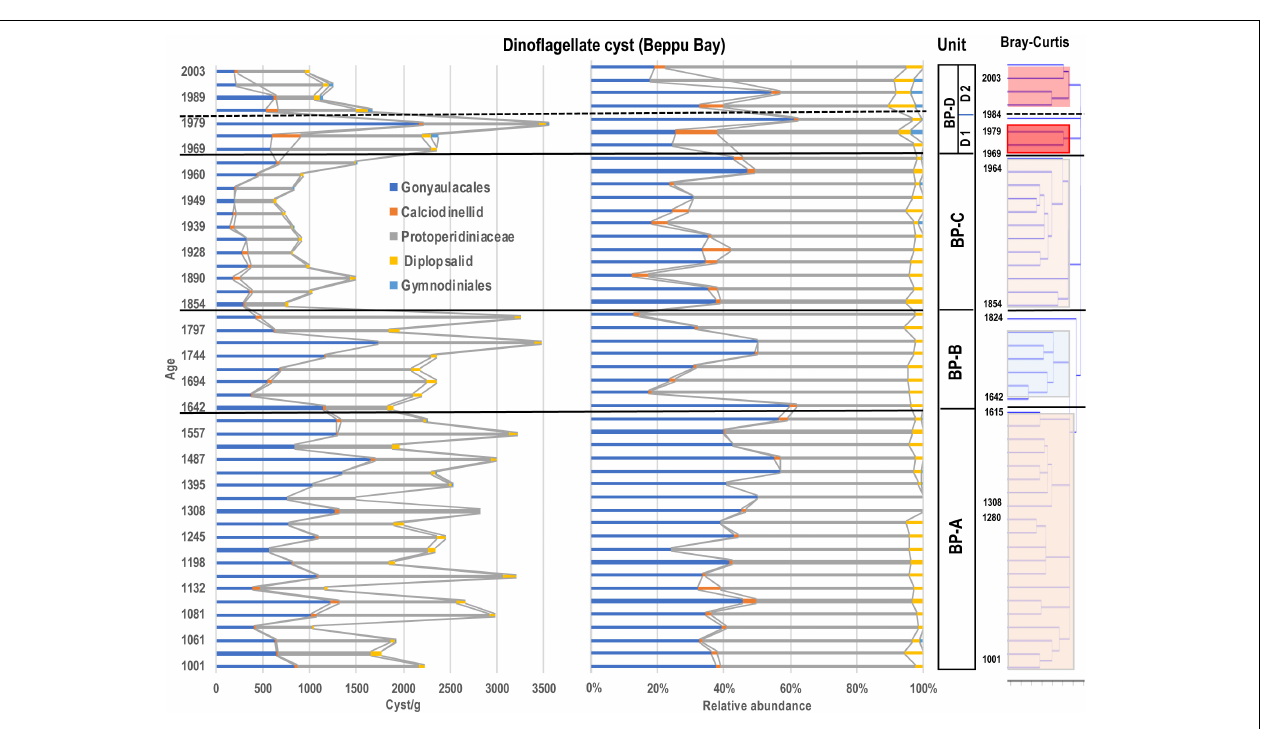
but after that, it increased (1005 eggs/g) until year 1944, and then decreased sharply until year 1960 (336 eggs/g). After that, it started to increase again (913